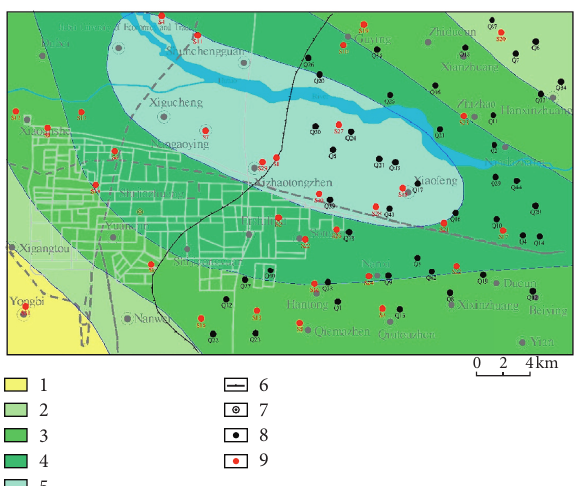
Figure 1: Study area and sampling locations: (1) water abundance of groundwater < 10m 3 /h · m; (2) water abundance of groundwater is between 10 and 30m 3 /h · m; 3) water abundance of groundwater is between 30 and 50m 3 /h · m; (4) water abundance of groundwater is between 50 and 70m 3 /h · m; (5) water abundance of groundwater > 70m 3 /h · m; (6) boundary of the drainage area; (7) villages; (8) sampling points of shallow groundwater; and (9) sampling points of deep